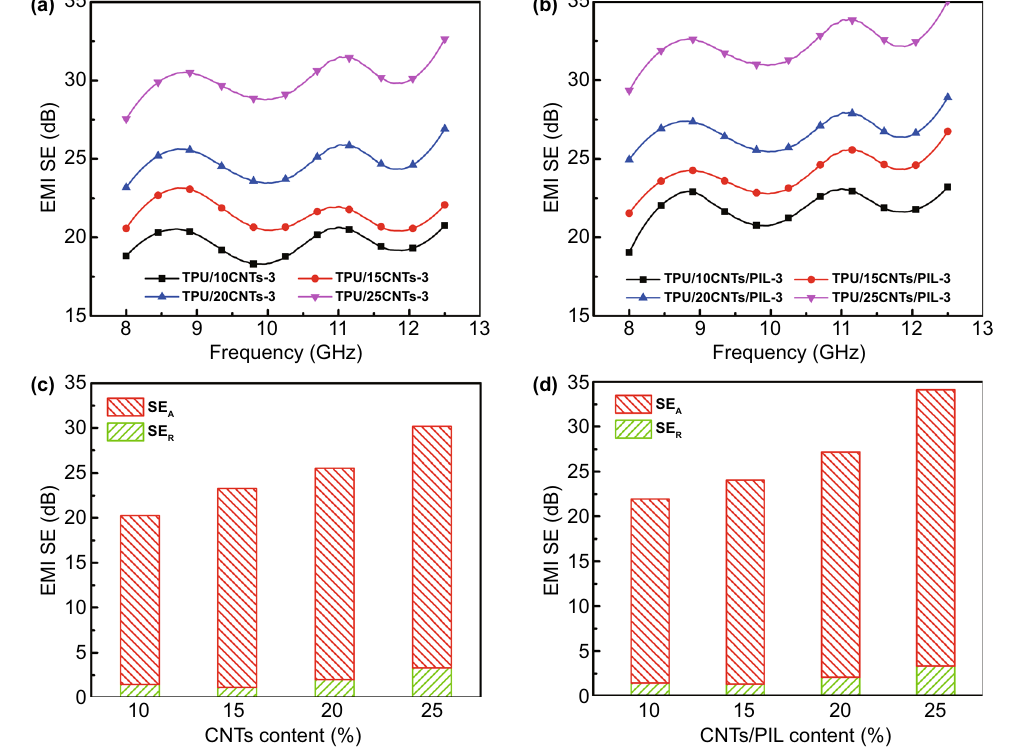
Fig. 3 EMI SE of TPU/CNTs a and TPU/CNTs/PIL b composite foams with 3 min evaporate time and various concentrations; SE A and SE R of TPU/CNTs c and TPU/CNTs/PIL d composite foams with 3 min evaporate time and various concentrations at 9.0